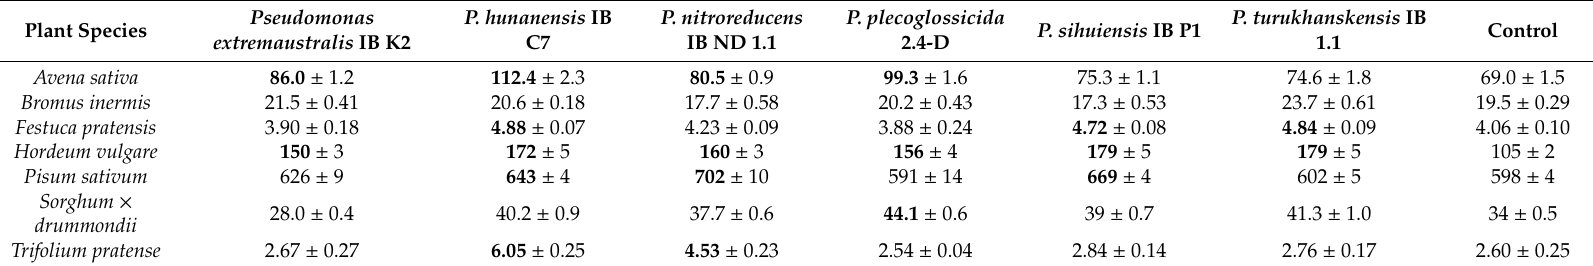
Table 6. E ff ect of inoculating seeds with strains of Pseudomonas bacteria on the mass of seedlings of plant species grown in Petri dishes in the absence of oil, hexadecane or